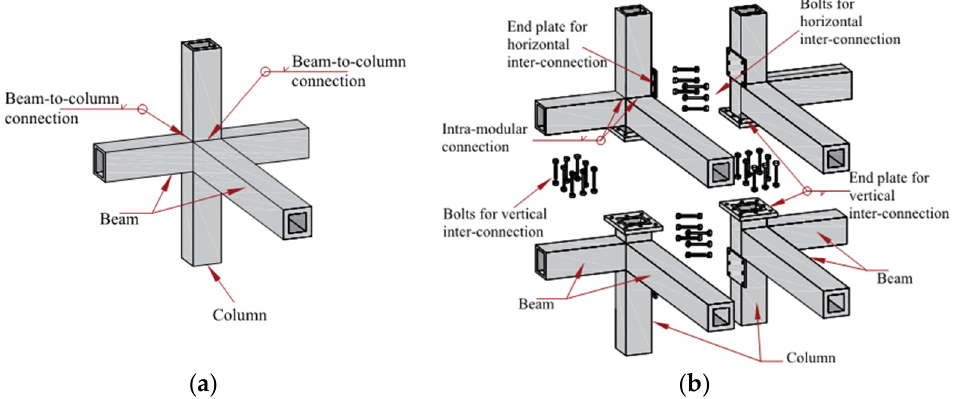
Figure 1. Details of a joint in ( a ) conventional ( b ) corner-supported modular structures.